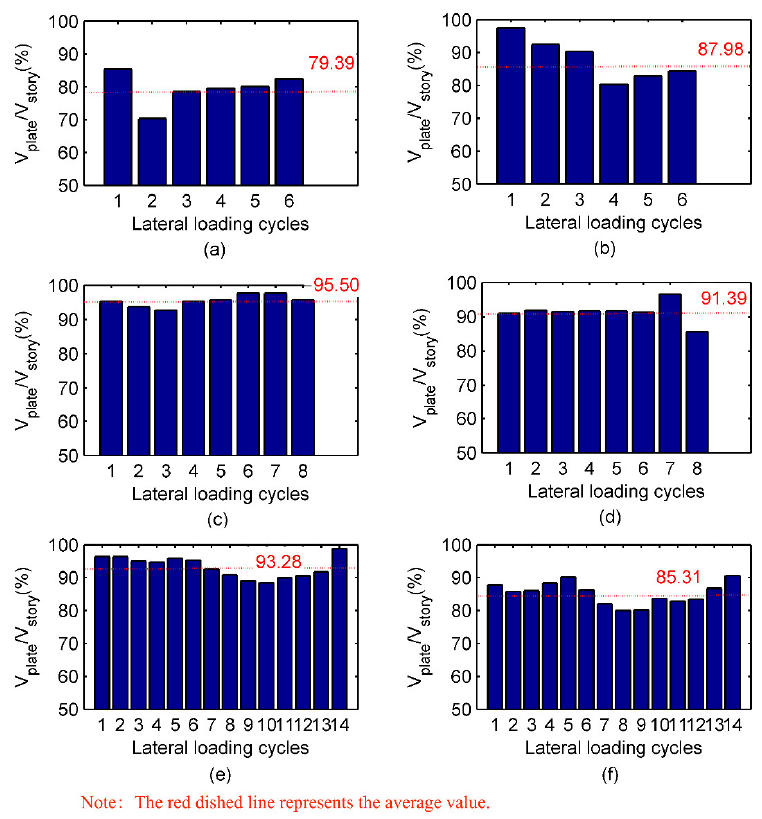
Figure 19. Proportion of shear forces resisted by shear walls: ( a ) the 1st story of specimen SPSW; ( b ) the 2nd story of specimen SPSW; ( c ) the 1st storey of specimen SPCSW; ( d ) the 2nd story of specimen SPCSW; ( e ) the 1st story of specimen DPCSW; ( f ) the 2nd story of specimen DPCSW.